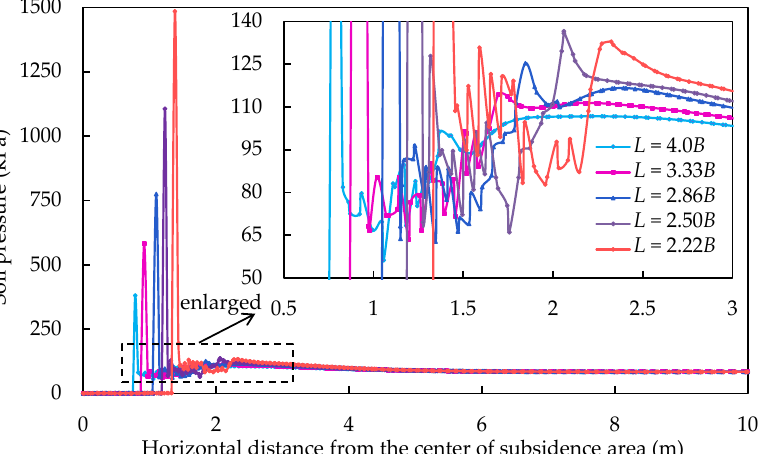
Figure 9. Vertical normal pressure distribution below the geotextile with different subsidence widths.